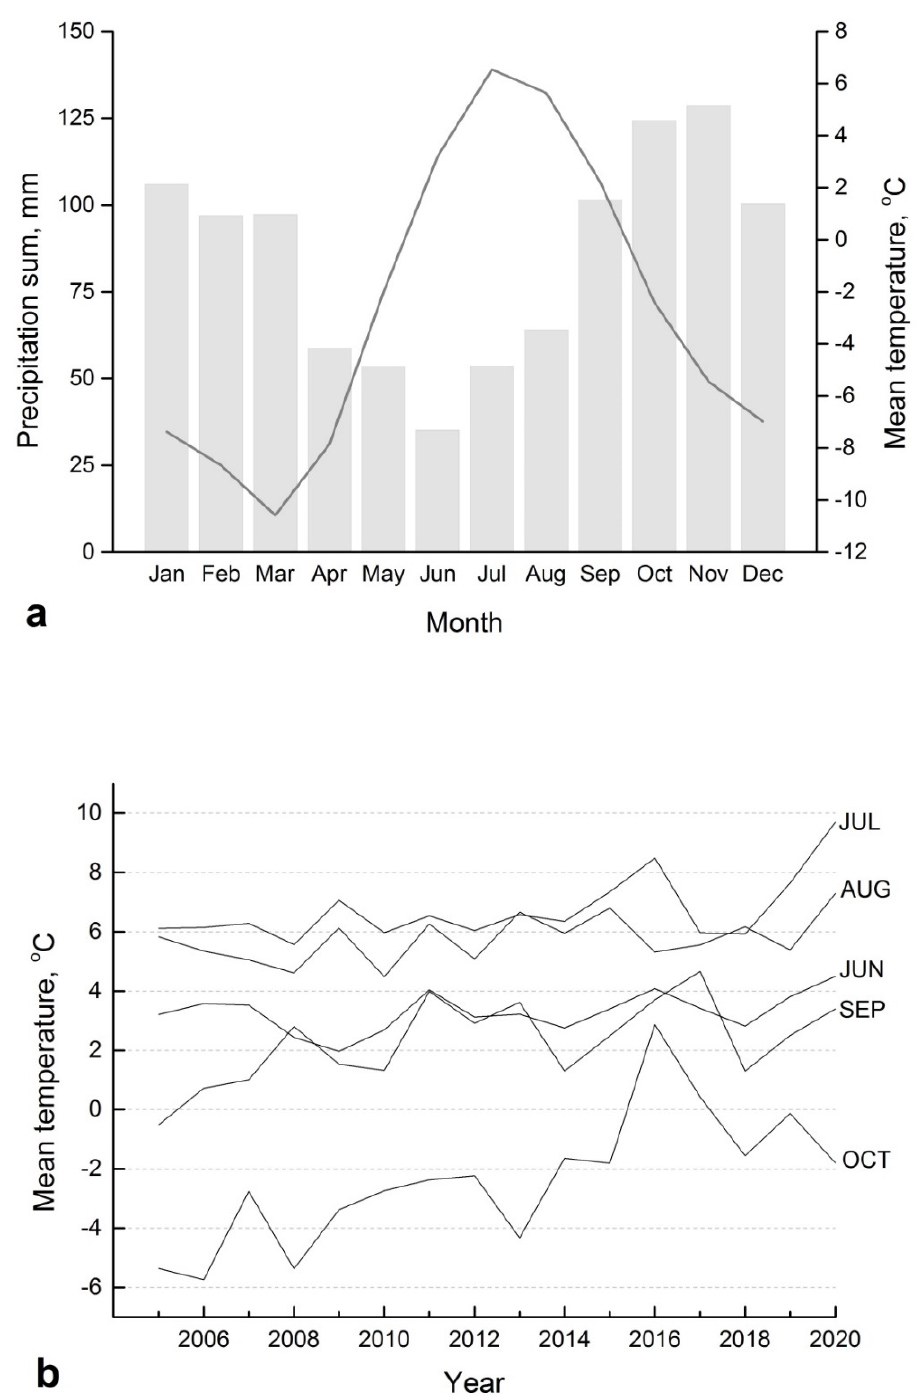
Figure 2. ( a ) Mean monthly temperature and precipitation values from 2005 to 2019 recorded on AWS Barentsburg; ( b ) Mean temperature values of the warmest months from 2005 to